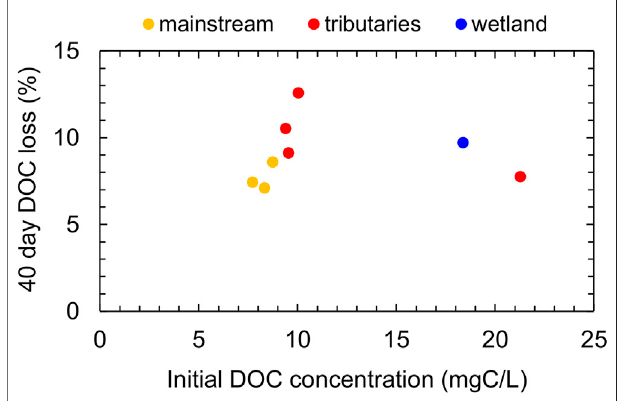
FIGURE 6 | DOC loss in the water of the Indigirka mainstream, tributaries, and wetlands observed in 2011 after 40 days of lab incubation at room temperature, compared with the initial DOC concentration.